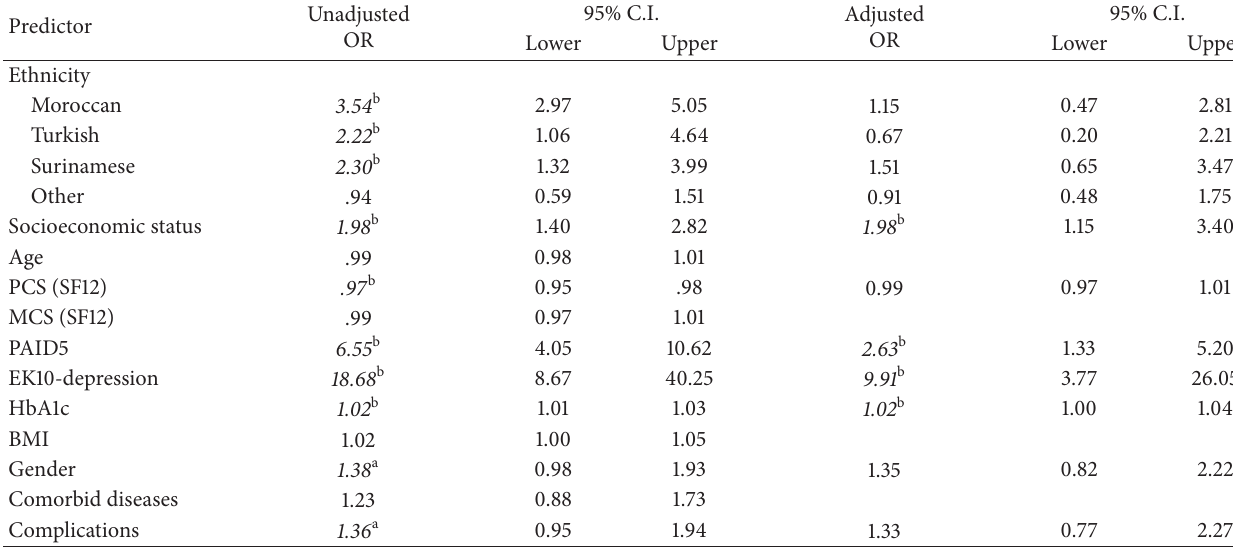
Table 6: Unadjusted and adjusted logistic regression analyses of variables associated with anxiety symptoms (EK10-anxiety). 95% C.I. 95% C.I. Unadjusted Predictor OR Upper Lower Upper Ethnicity